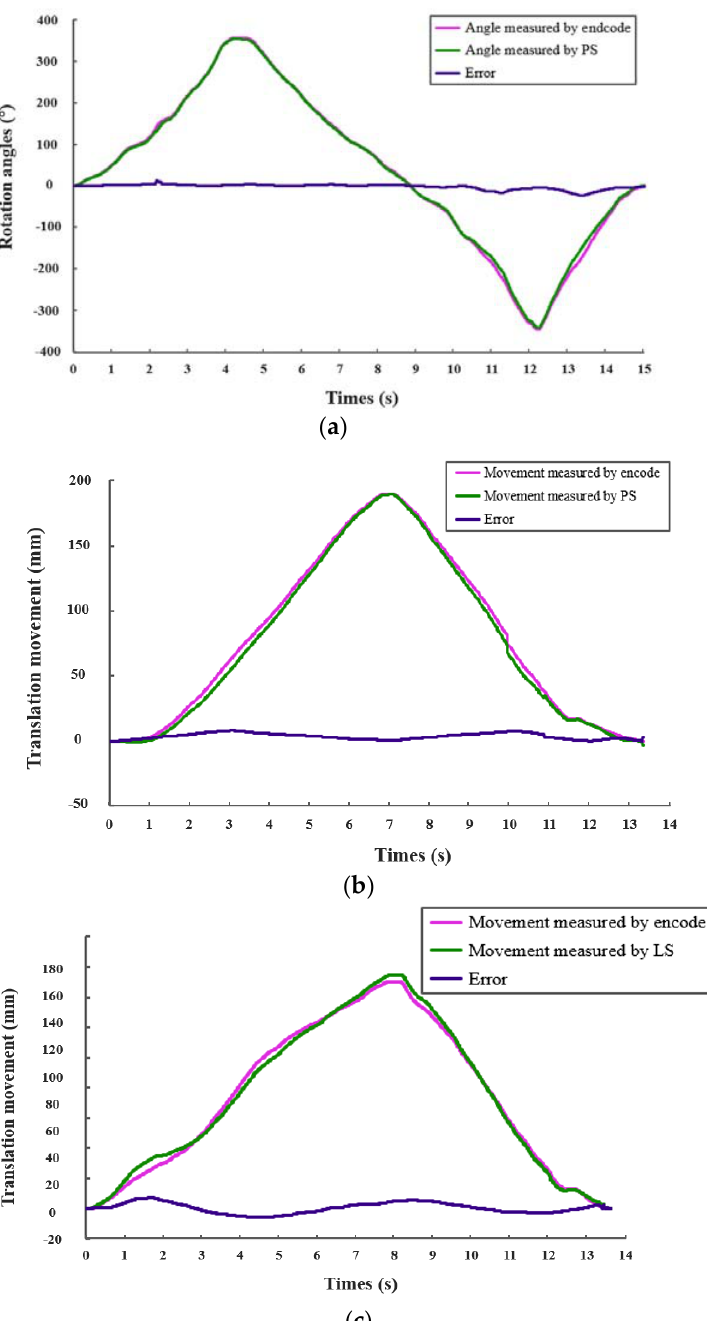
Figure 13. Experimental results for accuracy evaluation: ( a ) experimental result for rotation evaluation of catheter operating handle; ( b ) experimental result for translation evaluation of catheter operating handle; ( c ) experimental result for translation evaluation of guidewire operating handle.